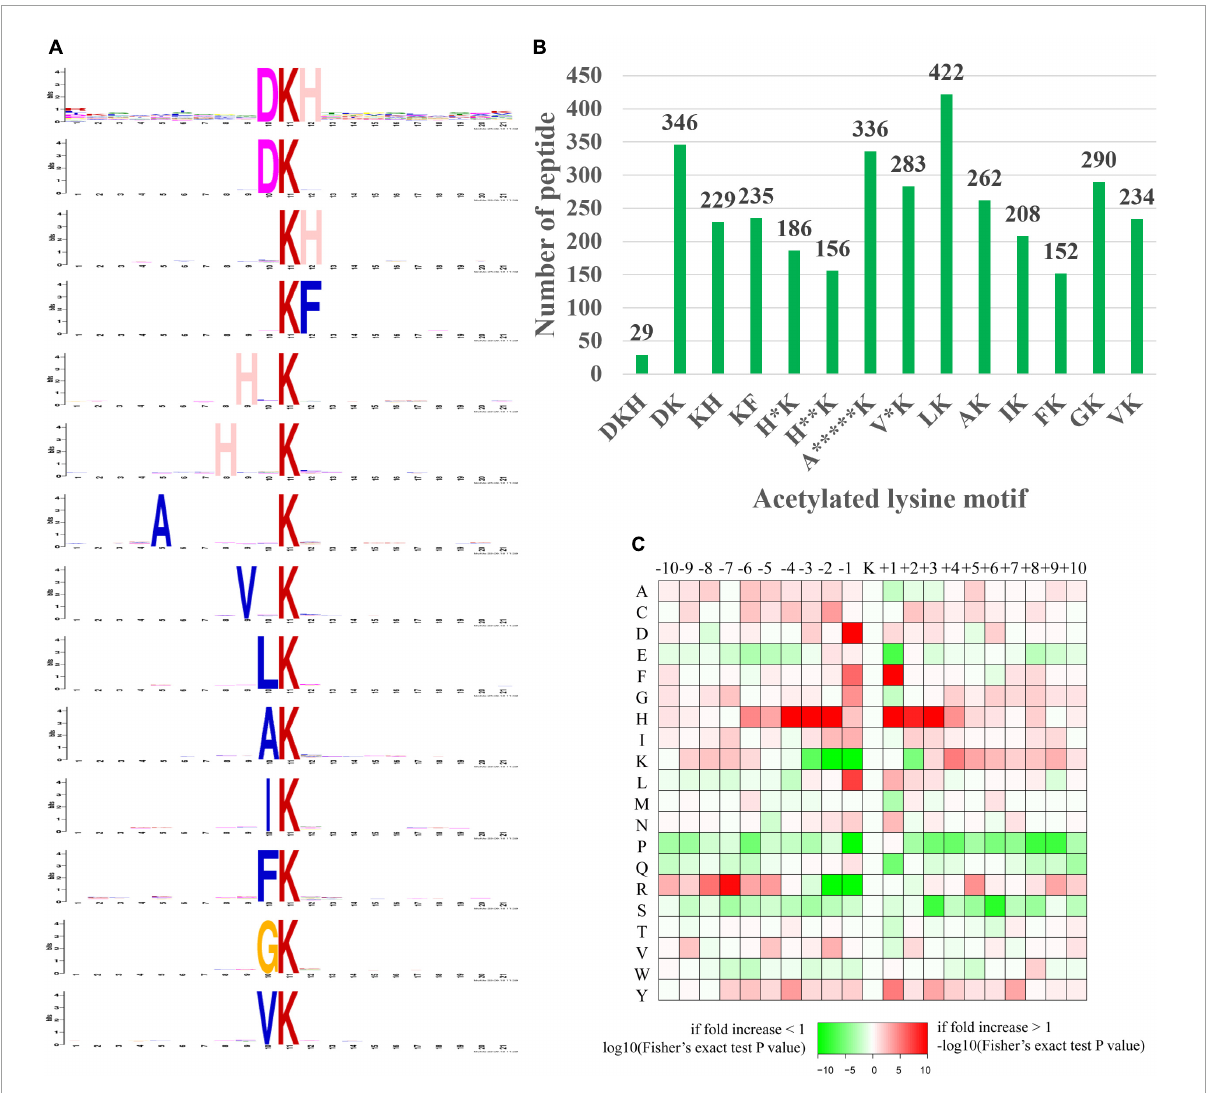
FIGURE9 Motif analysis of the identified acetylated peptides. (A) Sequence logo of motifs consisting of 20 residues surrounding the targeted lysine residue. (B) Number of identified peptides containing each motif. (C) Heat map of amino acid frequencies in specific positions, including enrichment (red) or depletion (green) of amino acids flanking Kac